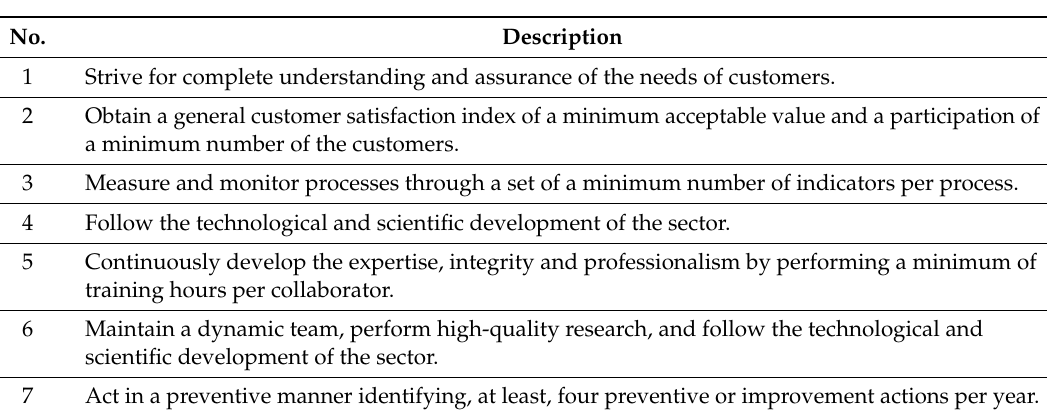
Table 3. List of specific operational quality